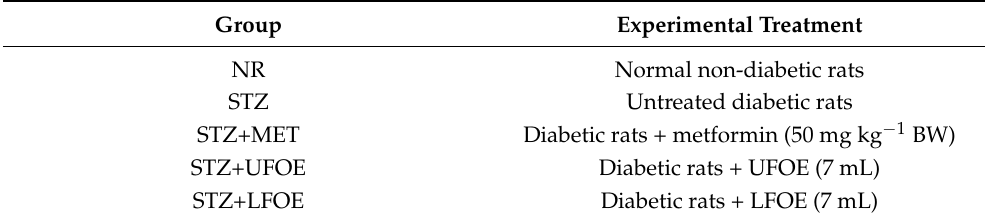
Table 1. The experimental design of Streptozotocin-induced diabetic rats treated with the LFOE for 6 weeks. Group Experimental Treatment NR Normal non-diabetic rats STZ Untreated diabetic rats STZ+MET STZ+UFOE Diabetic rats + UFOE (7 mL) STZ+LFOE Diabetic rats + LFOE (7